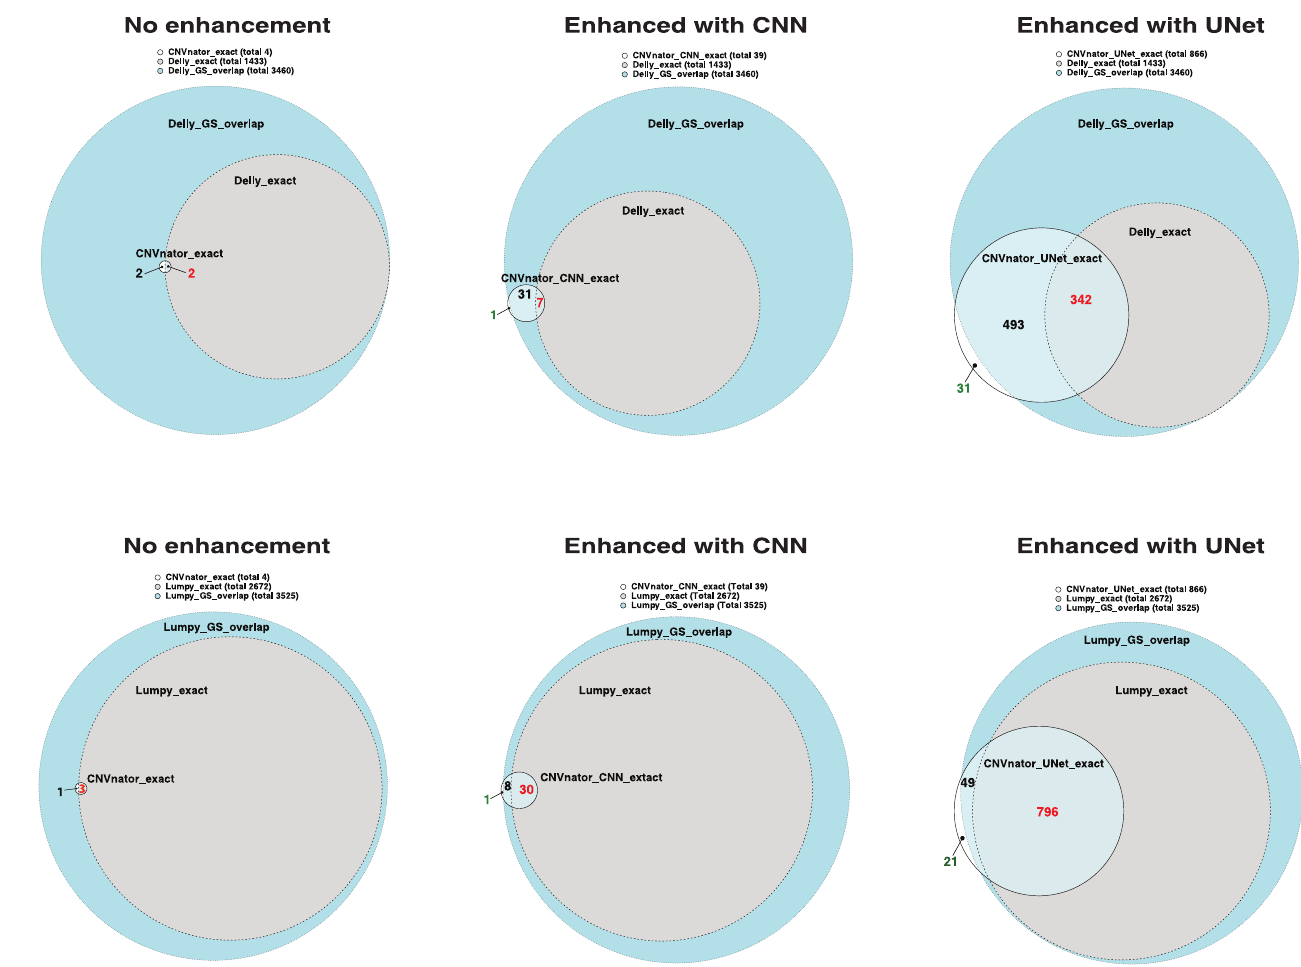
Fig 4. Comparison of the enhanced RD-based SV callers with two different SV callers on the simulated data. Evaluated SVs are the ones that overlap with the gold- standard SVs (Jaccard similarity > 0.5). SVs with exact breakpoints (both-boundary-match, which is abbreviated as “ � _exact”) predicted by CNVnator (w/wo enhancement) are compared with the GS-ov SVs predicted by Delly and Lumpy, which are shown in the following Venn diagrams. Any two predicted SVs are treated as overlapped as long as they overlap with the same gold-standard SV. The Venn diagrams were plotted using Eulerr [20]. (A) Comparison of CNVnator (w/wo enhancement) and Delly. (B) Comparison of CNVnator (w/wo enhancement) and Lumpy.